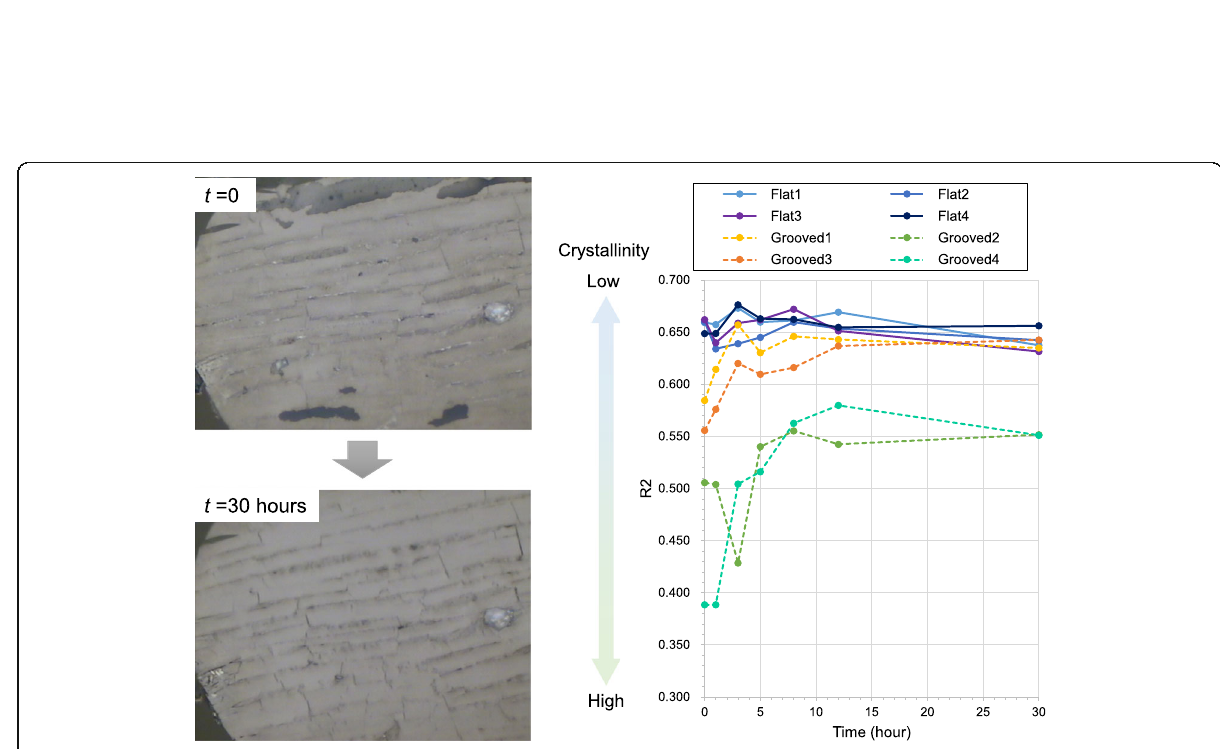
Fig. 5 Change of the graphite crystallinity by chemo-mechanical polishing using colloidal silica. Chemo-mechanical polishing was operated using VibroMet ™ 2 Vibratory Polisher. The photographs on the left show the reflection microscopic images of the graphite before and 30 h after the chemo-mechanical polishing. The graph on the right shows the changes of graphite crystallinity (=R2) with time. The data in the flat part are indicated by solid lines, and the data of grooved band are indicated by dotted